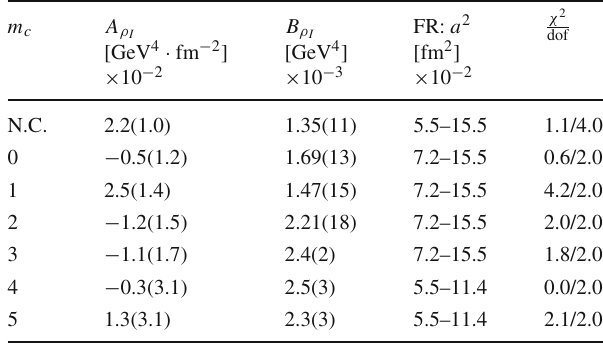
Table7 Theinterpolatedresultsofthenumberdensityoftheinstantons and anti-instantons ρ I , square root of the number density ρ